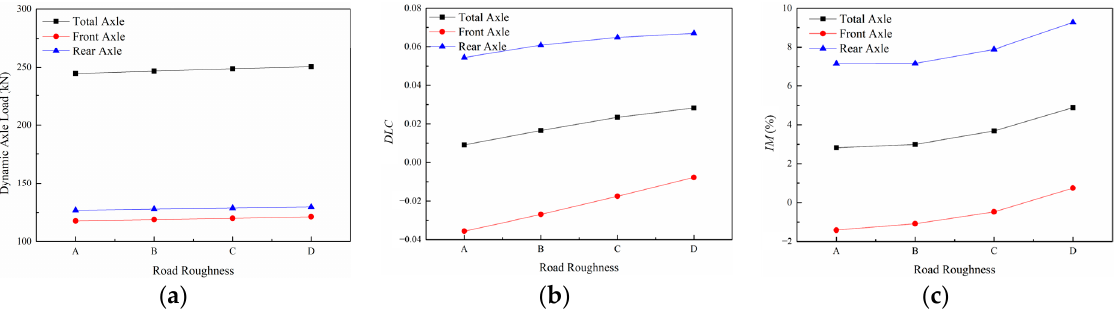
Figure 19. Dynamic axle load in curved road sections with different road roughness under simulation conditions. ( a ) Dynamic axle load. ( b ) DLC . ( c ) IM .